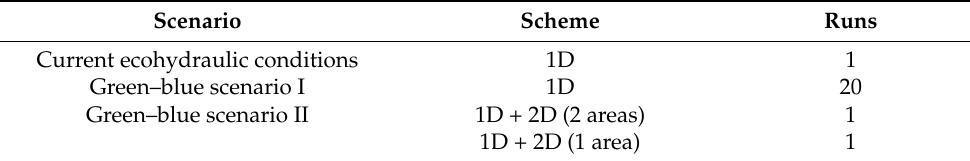
Table 4. Main features of the unsteady hydraulic simulations performed here: Scenarios, numerical scheme, number of simulations, here indicated as